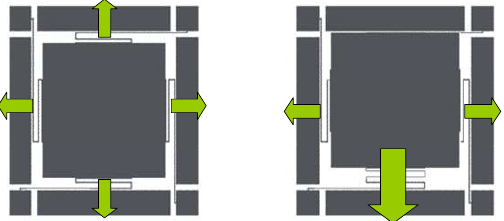
Fig. 3. Top views of a microactuator in neutral and working